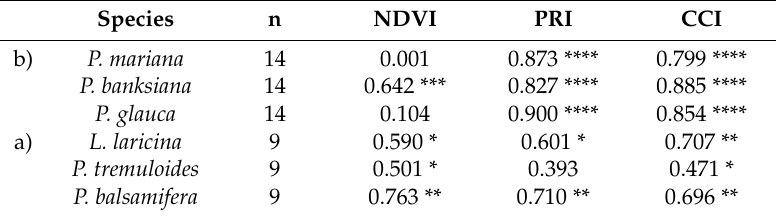
Figure 5. Correlations between F S and canopy-level optical indices NDVI, PRI, and CCI for evergreen ( a − c ) and deciduous ( d − f ) species. Data points were obtained near solar noon from January 2016 to December 2016. Error bars denote ±SE of the mean. Table 2. Linear correlation coefficients ( r 2 ) between canopy-level optical indices NDVI, PRI, CCI and Fs for evergreen ( a ) and deciduous ( b ) species. Data points from the spring transition in 2016 for P. glauca and P. mariana were excluded from analyses.